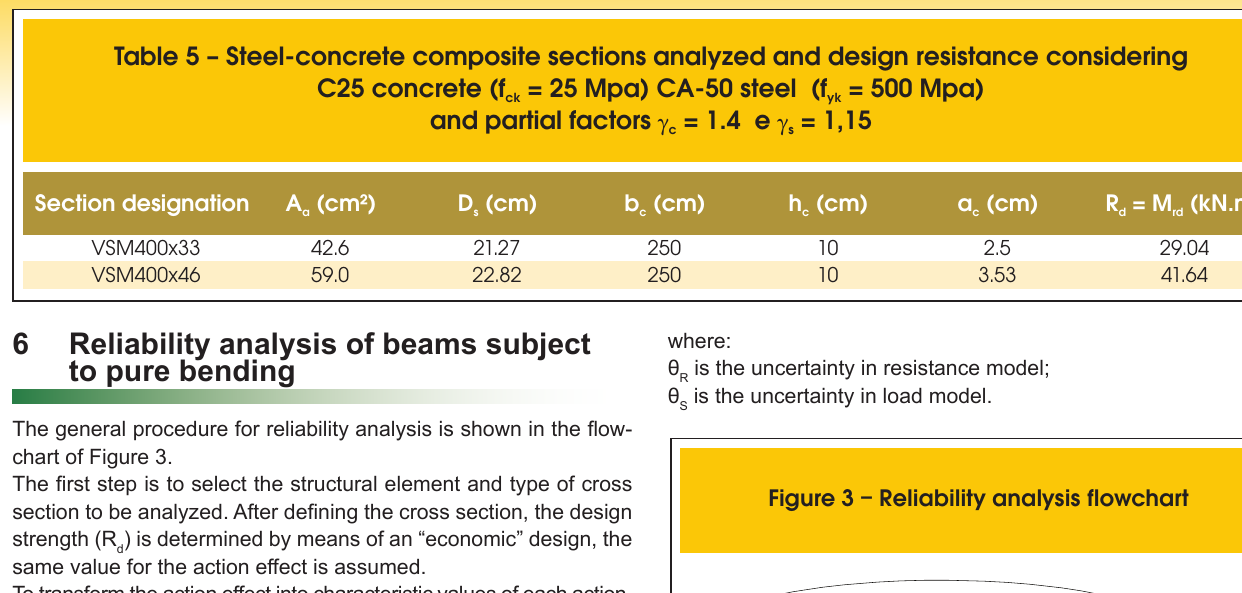
Choice of structural element and